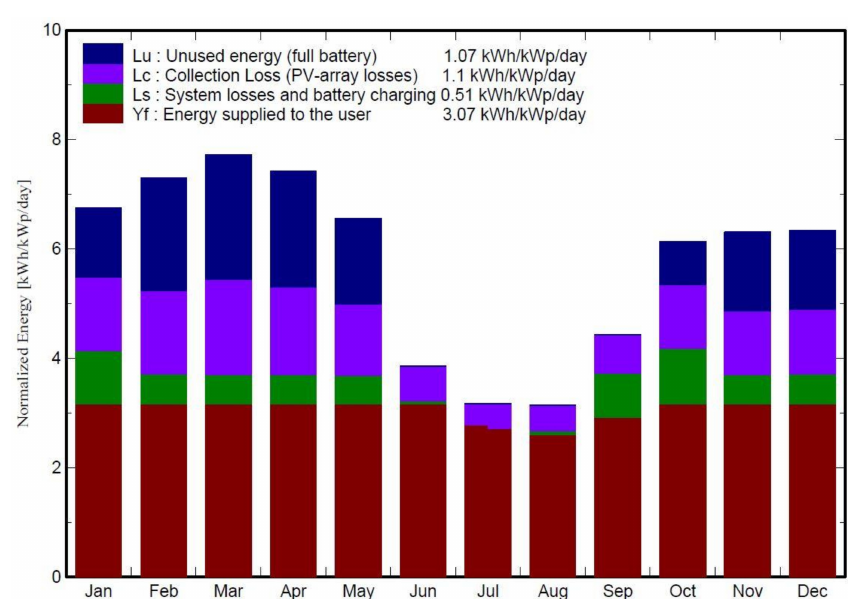
Figure 23. PVsyst per day monthly PV energy output estimates normalised per